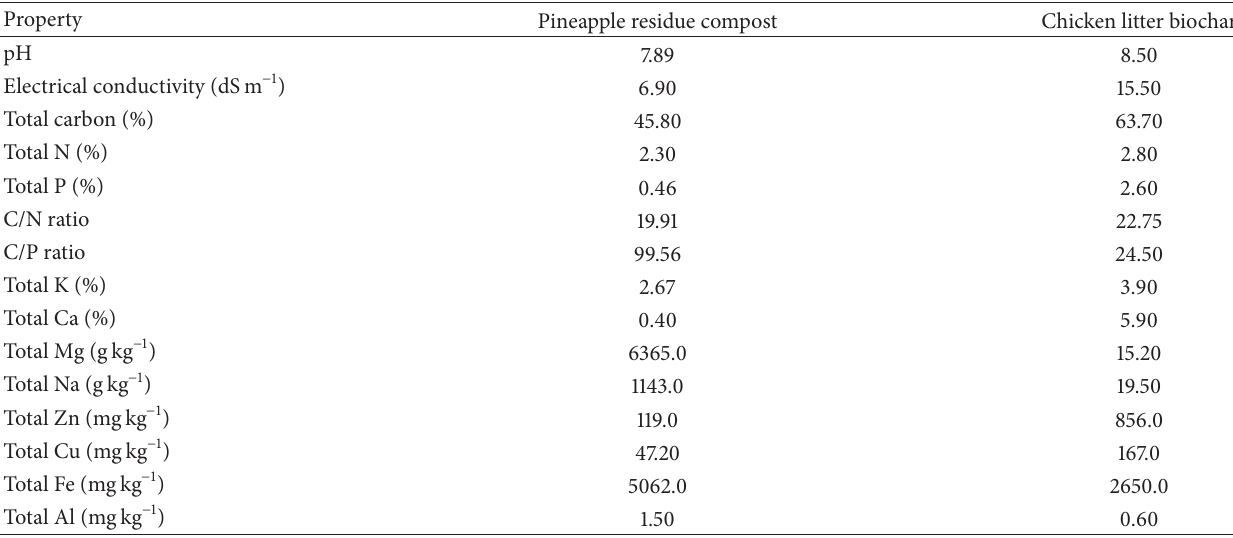
Table 2: Selected chemical properties of chicken litter biochar and pineapple residue compost.